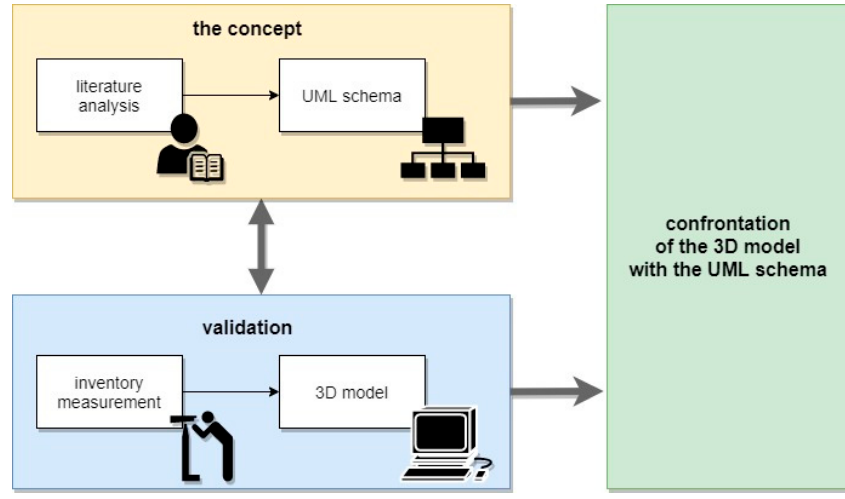
Figure 1. Research methodology. Source: own study.